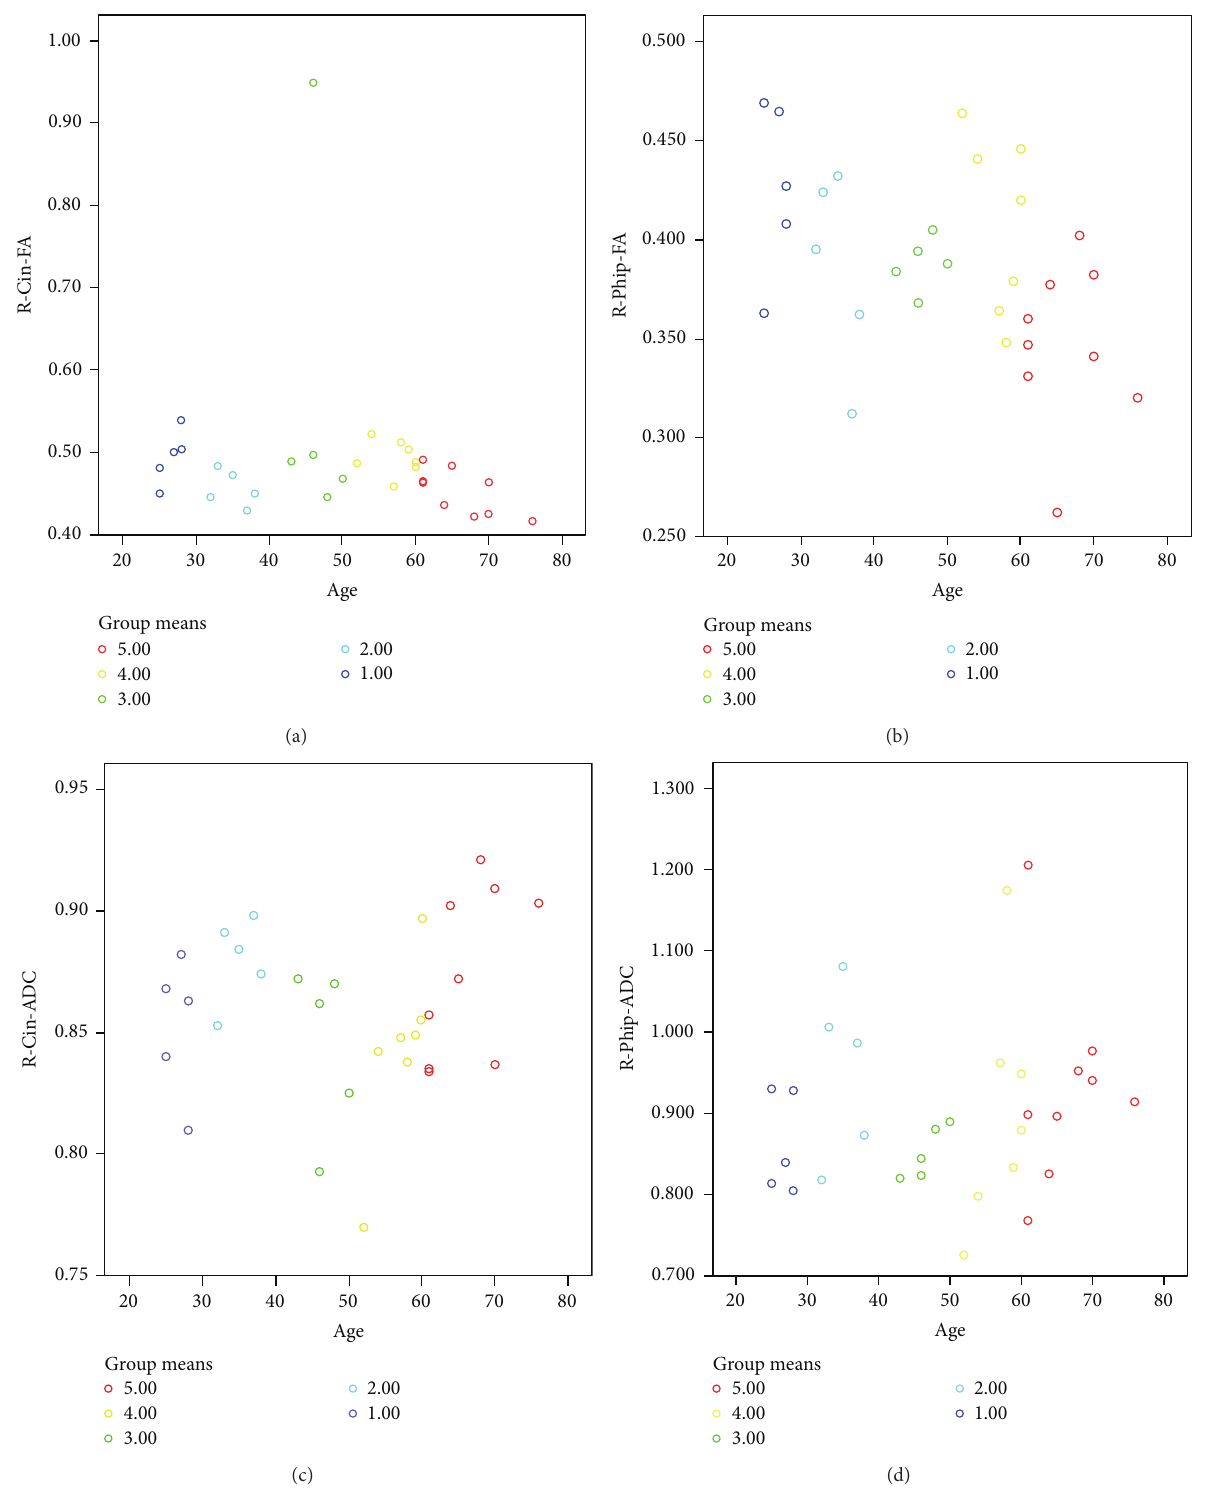
Figure 4: In group analysis, both sides parahippocampal and cingular FA and ADC values were statistically different between groups ( 𝑃 < 0.05